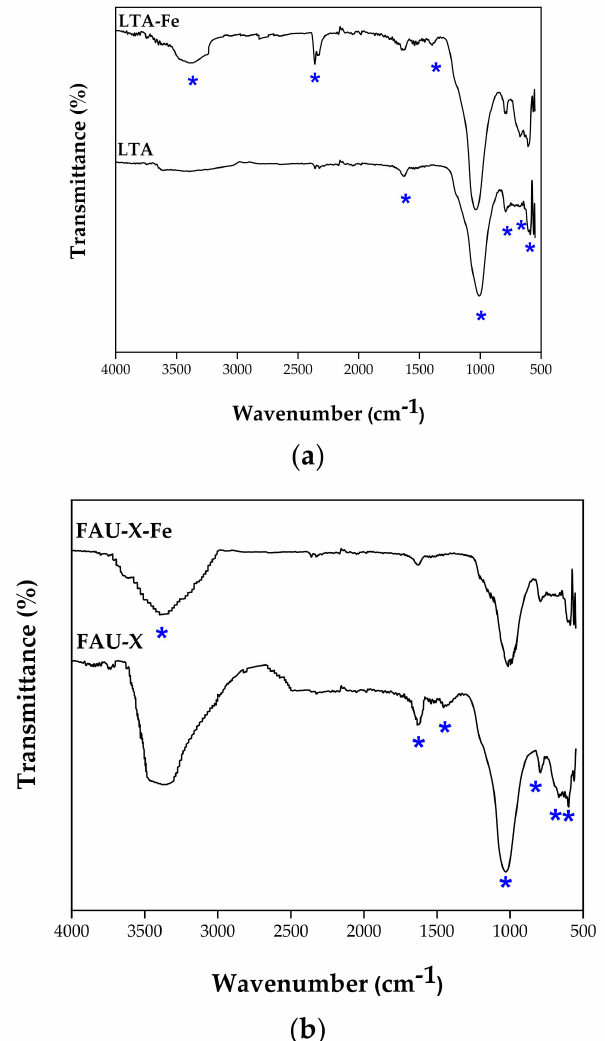
Figure 5. FTIR of the ( a ) LTA zeolite in parent and iron form LTA-Fe, ( b ) FAU-X zeolite in parent and iron form